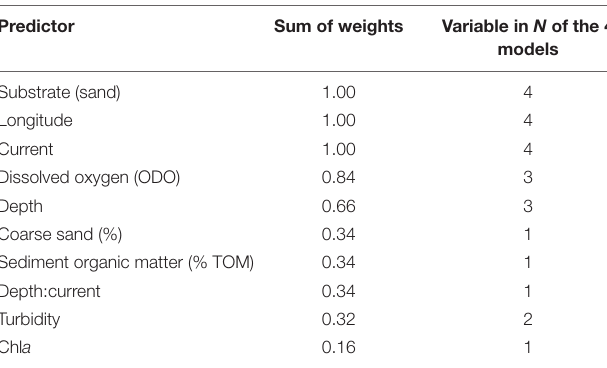
TABLE 4 | Model importance values extracted from the GLM averaged model, considering the four top models with a (cid:49) AIC < 2. Predictor Sum of weights Variable in N of the 4